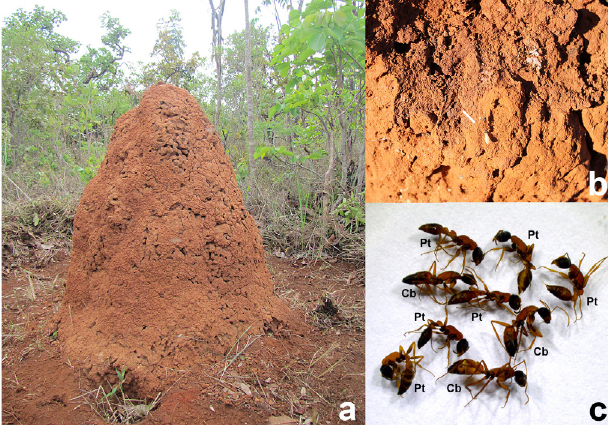
Fig. 1 A typical termitary of Cornitermes cumulans in the Brazilian Cerrado ( a ), worker of Pseudomyrmex termitarius foraging solitarily on a termitary ( b ), mixed sample from a nest chamber containing individuals of Camponotus blandus (Cb) and Pseudomyrmex termitarius (Pt) ( c